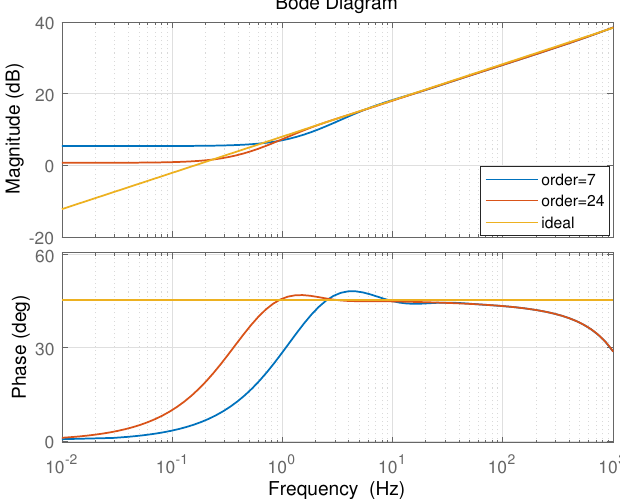
Figure 9. Bode diagram of fractional order operator s 0.5058 .